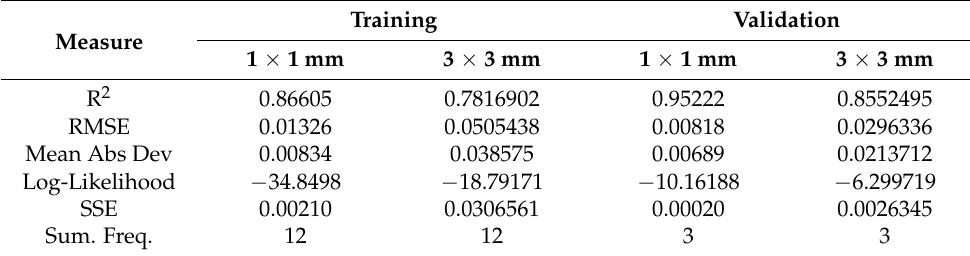
Table 4. Training and validation measures obtained for Y c dependent